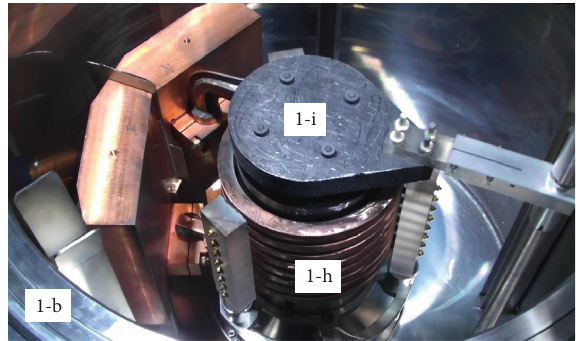
Figure 4: Induction coil and furnace cap located inside the lower chamber of injection-casting furnace.